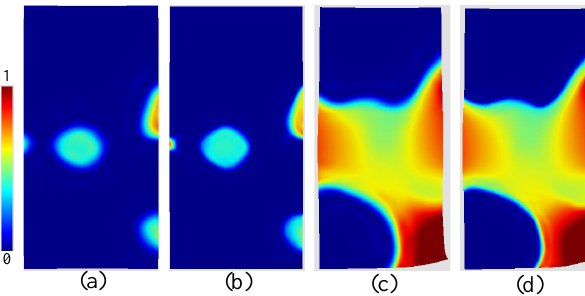
Figure 19. Damage responses at t = 43 µ s for the domain with l c = 40 mm with different meshes and load amplitudes: ( a ) low amplitude-medium mesh, ( b ) low amplitude-fine mesh, ( c ) high amplitude-medium mesh, and ( c ) high amplitude-fine mesh.